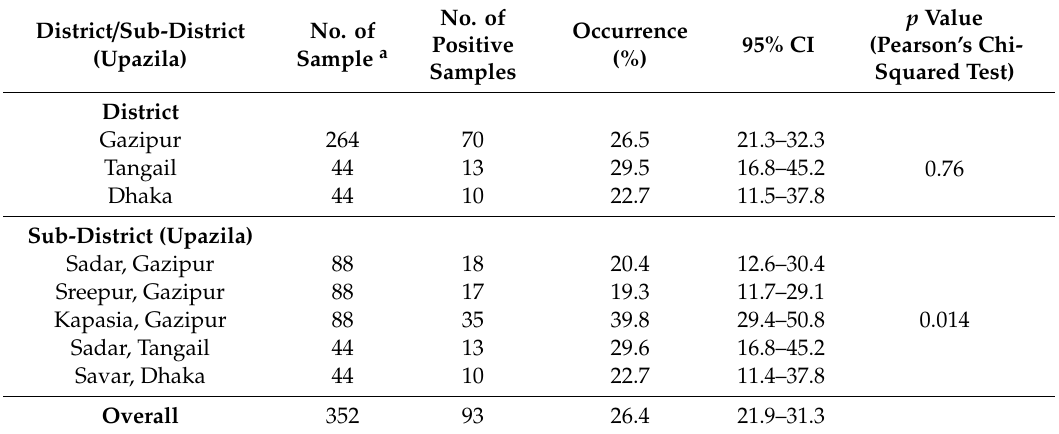
Table 3. Occurrence of Campylobacter spp. in broiler farms of 3 districts of Bangladesh ( N = 352